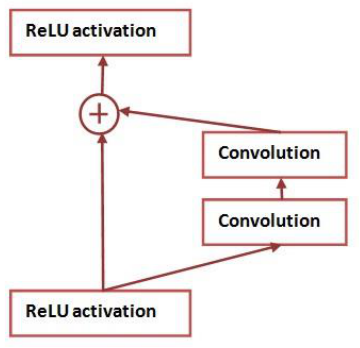
Figure 26. ResNet architecture.